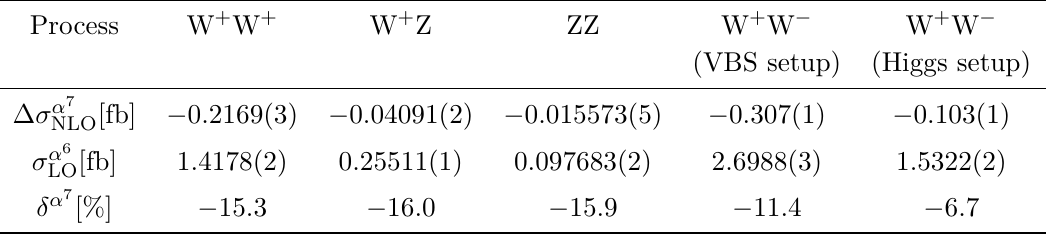
(cid:0) (cid:1) α 7 and LO cross section of O